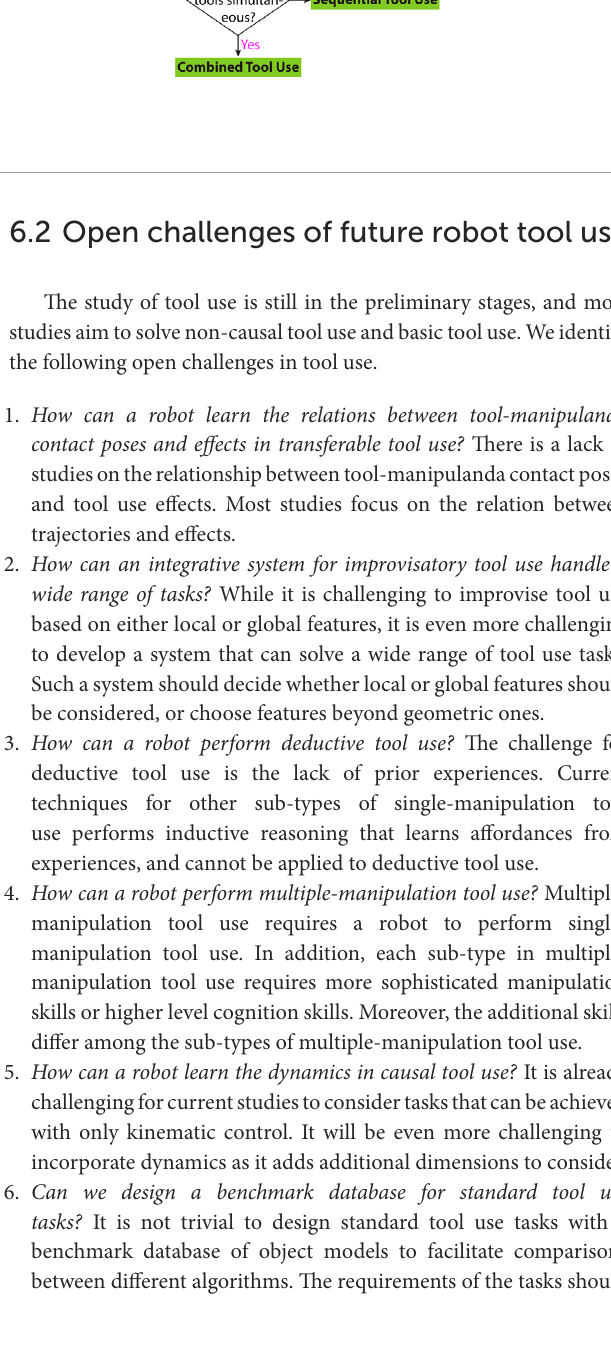
FIGURE 5 A cheat sheet for developing robot tool use applications.